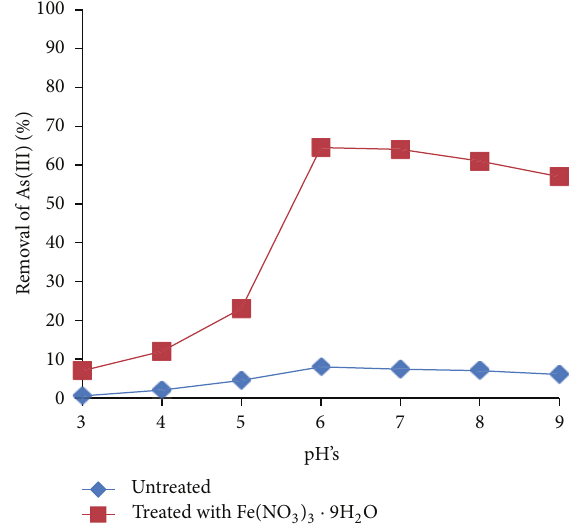
Figure 1: As(III) removal by untreated and treated iron-coated biomass at different pH’s. 1mg/L As(III), 30 ∘ C, 100rpm, 1 g of fungal biomass of Paecilomyces